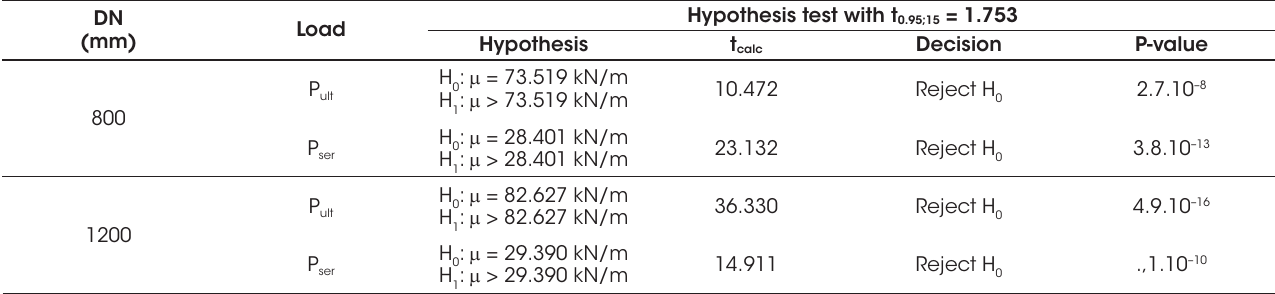
and P ( α = 5% and DV with mean values) ult ser